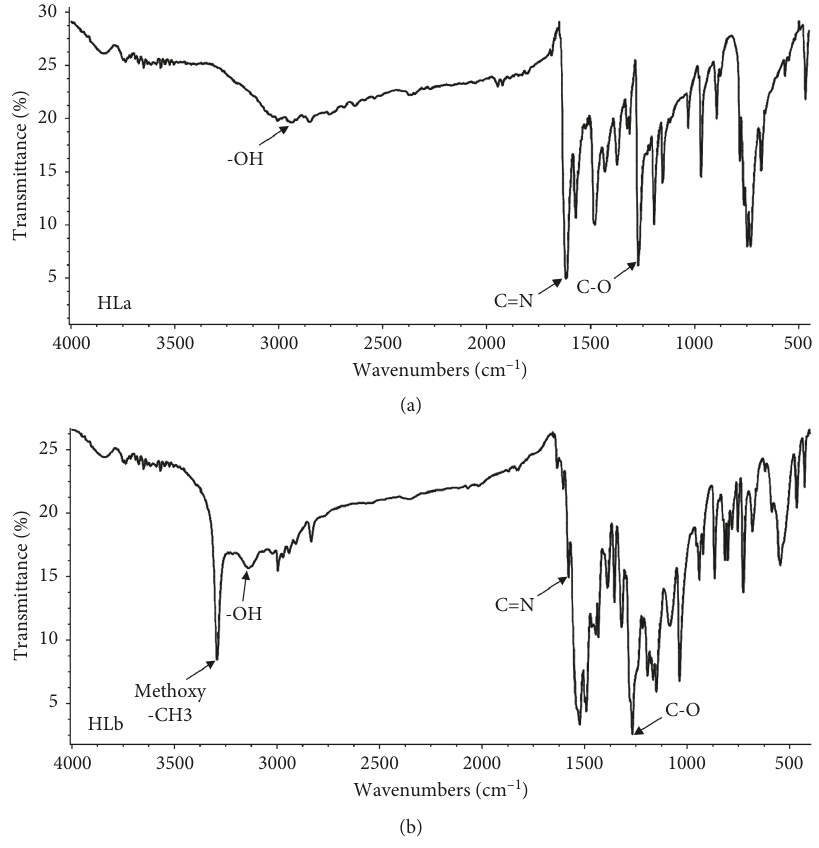
Figure 2: Infrared spectrum of (a) HLa and (b) HLb.